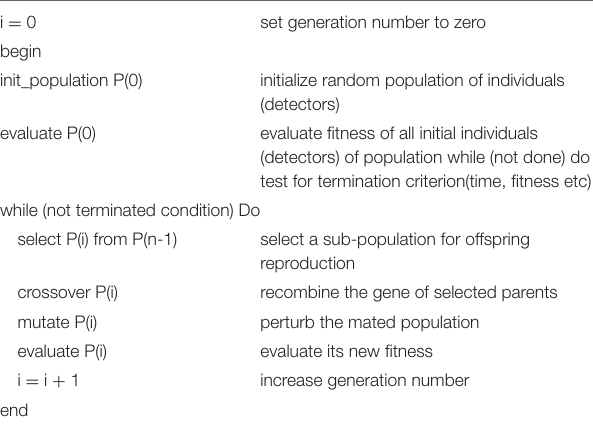
TABLE 4 | Pseudo code–GA for optimization of detectors.